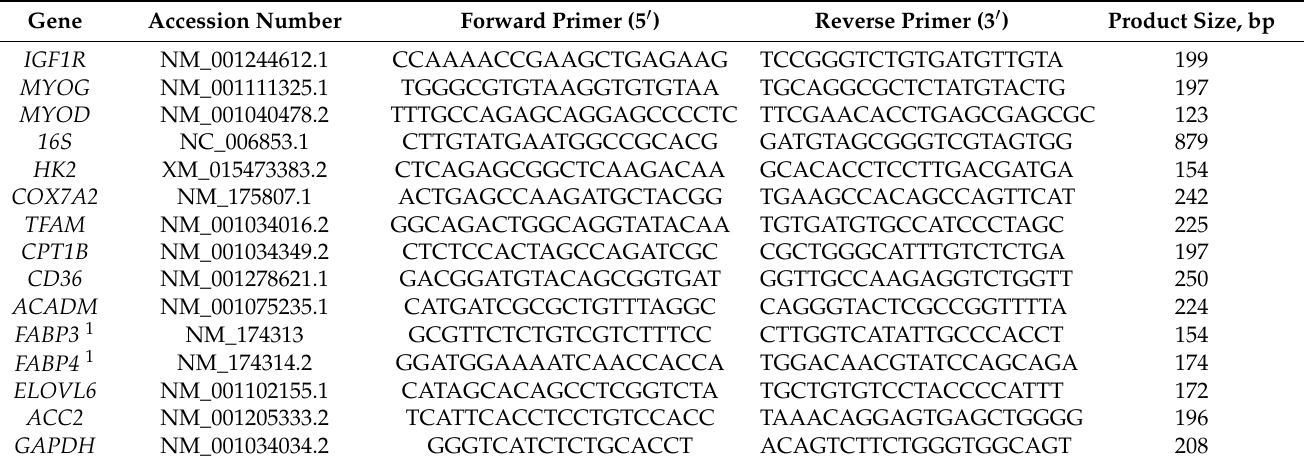
Table 2. Primer sequences for